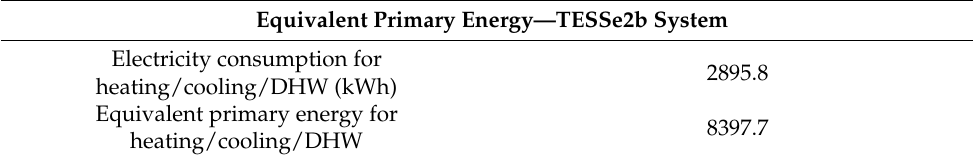
Table 3. Equivalent primary energy for the TESSe2b